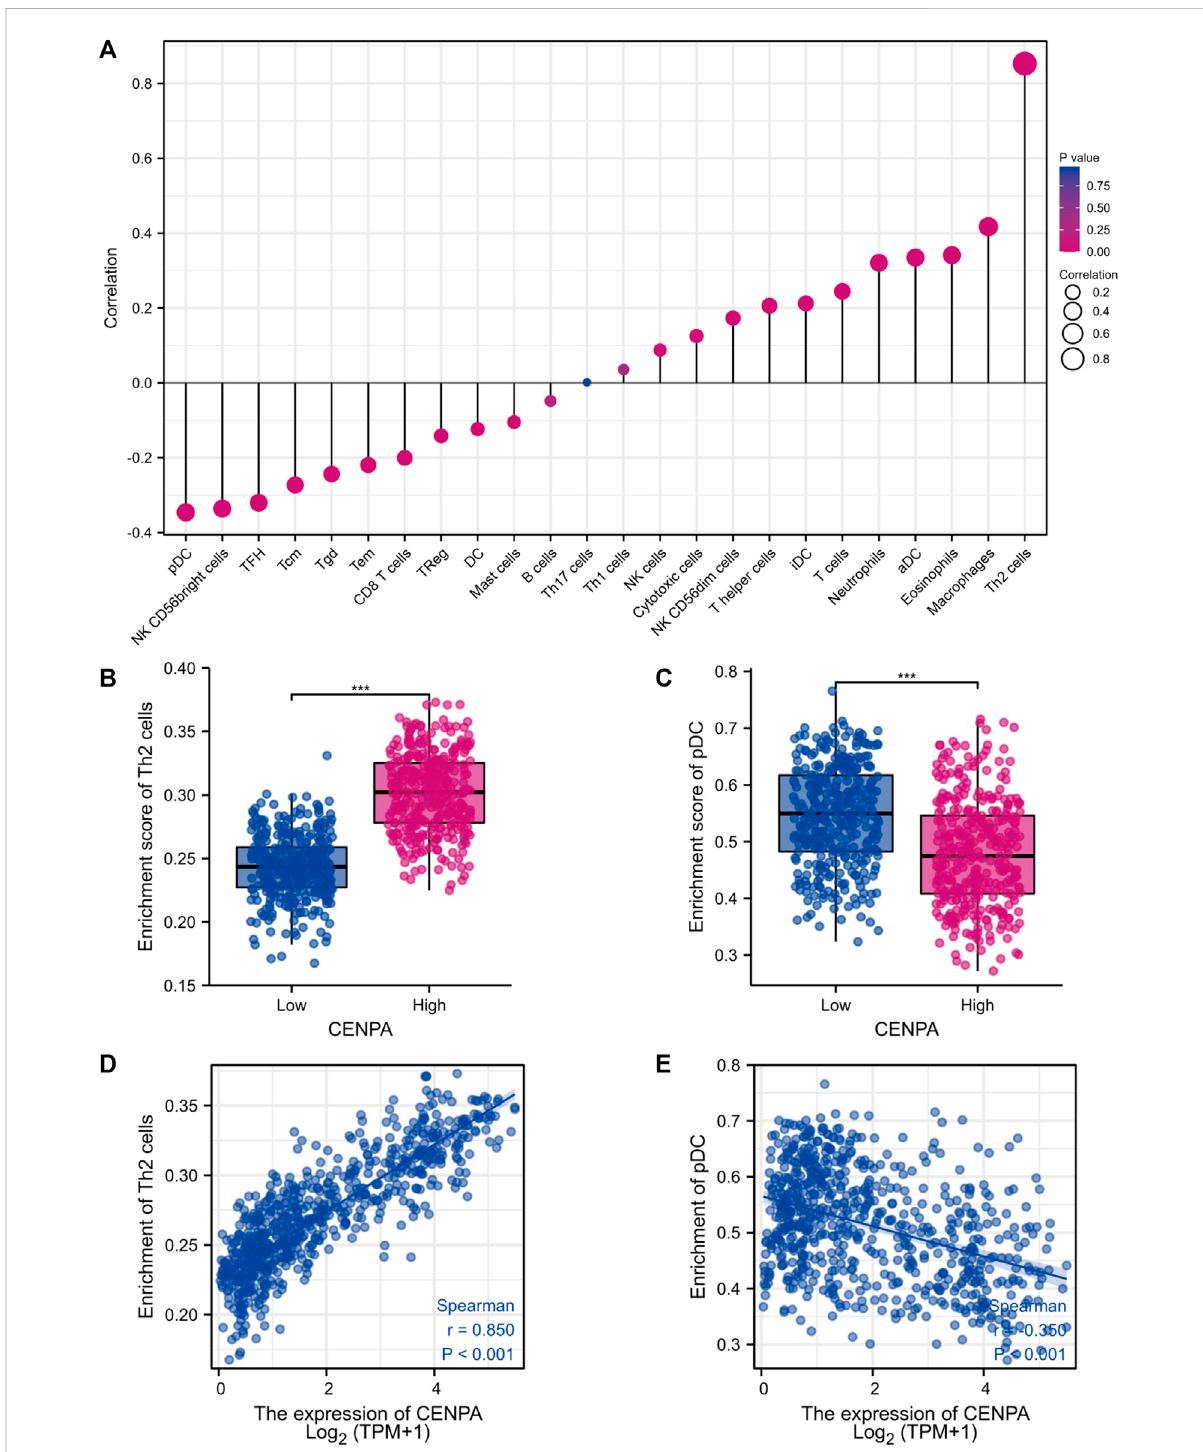
FIGURE 8 TheroleofCENP-Aintumorimmuneresponses. (A) Aforestplotshowingtheassociationbetween CENP-A expressionandimmunein fi ltration level. (B,C) The abundances of Th2 cells and pDC cells among low- and high- CENP-A expression groups. (D,E) The correlation between CENP-A expression levels and the relative enrichment levels of Th2 and pDC